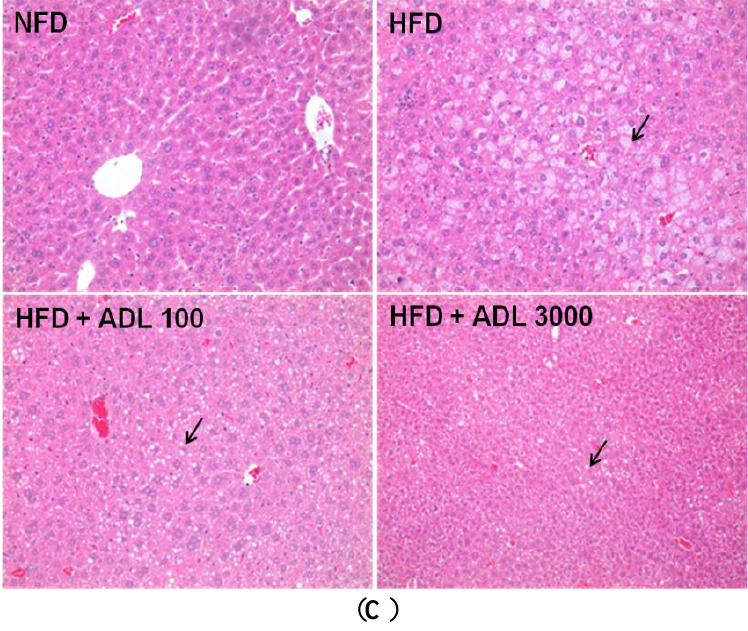
Figure 1. Histology of epididymal adipose ( A ) and liver ( C ) tissues of mice fed experimental diets for six weeks (magnification= ×200). Normal-fat diet (NFD), high-fat diet (HFD), high-fat diet with 100 mg·kg −1 ·day −1 Allomirina dichotoma larva suspension (HFD + ADL 100), and HFD with 3000 mg·kg −1 ·day −1 ADL (HFD + ADL 3000). Epididymal adipose cell volume measured by IMT i-Solution Lite program ( B ). Histopathology of the liver with steatosis. Arrows indicate the macrovesicular lipid droplets in the cytoplasm of hepatocytes ( C ). Results are expressed as mean ± SD ( n = 3). Statistical significance was evaluated by